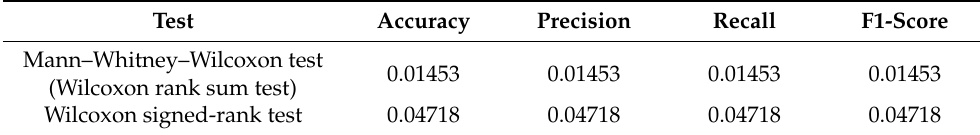
Table 9. The reported p values for